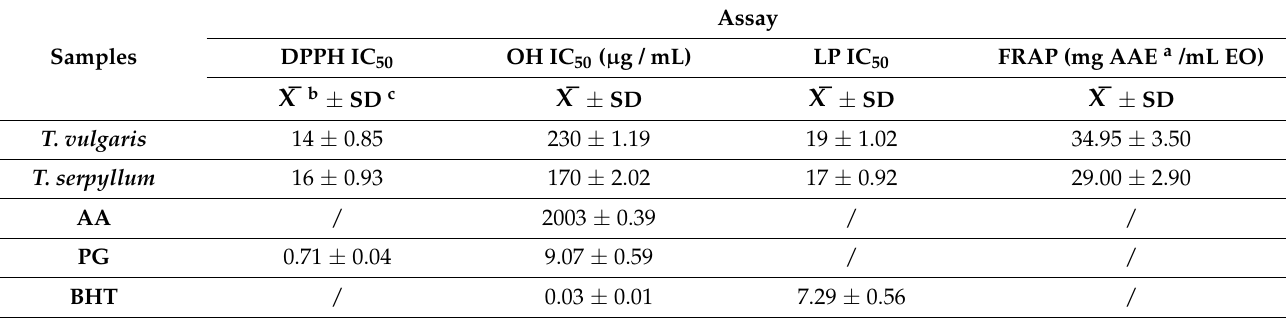
Table 3. Antioxidant potential of the investigated essential oils of T. serpyllum and T. vulgaris and positive control substances ( AA —ascorbic acid ; PG —propyl gallate ; BHT — tert- butylated hydrox- ytoluene). FRAP, ferric reduction antioxidant potential; DPPH, 2,2-diphenyl-1-picrylhydrazyl; OH, hydroxyl; LP, lipid peroxidation. Assay Samples DPPH IC 50